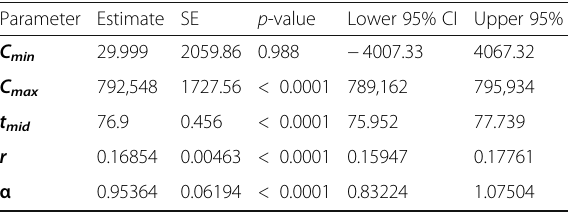
Table 1 Summary of parameter estimation Parameter Estimate SE p